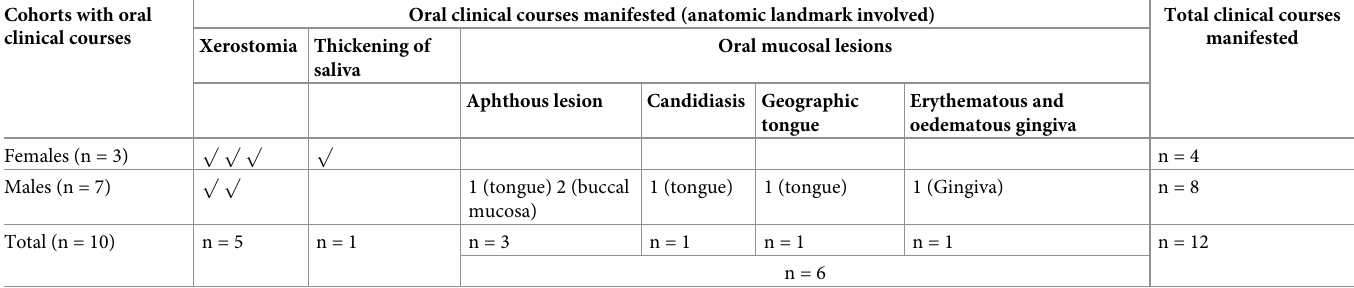
p Table 1. Oral clinical courses ( ) manifested among patients with SARS-CoV-2 infection during the hospital-based follow-up. Cohorts with oral clinical